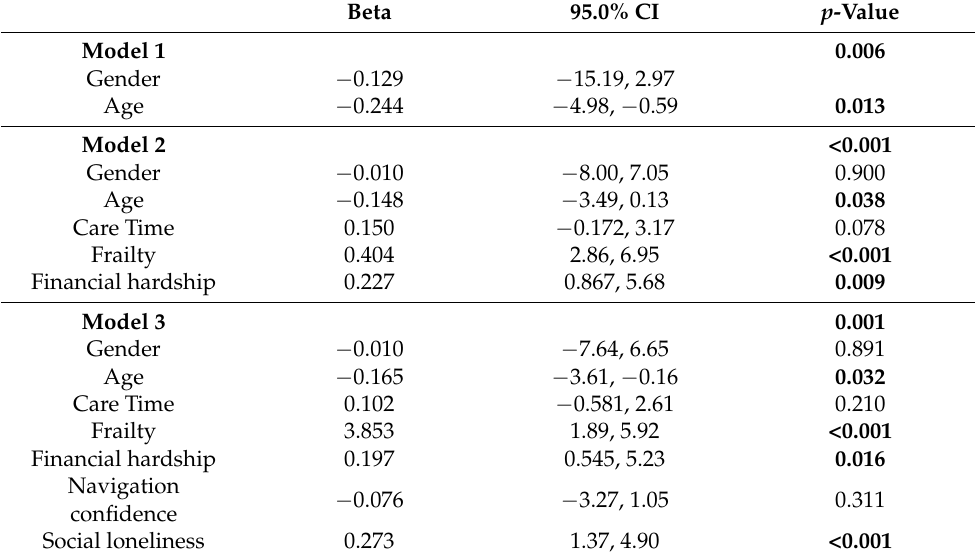
Table 3. Hierarchical linear regression model for anxiety a ( n =